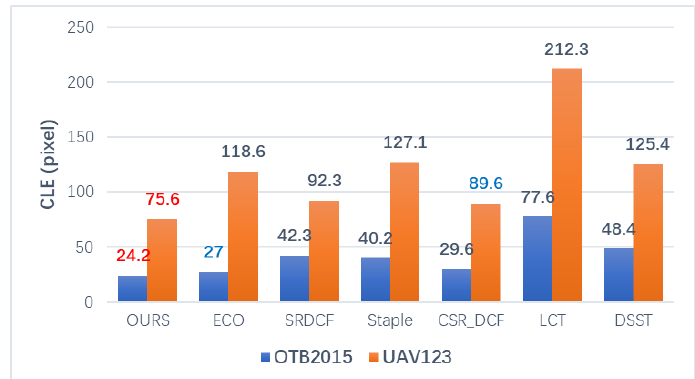
Figure 6. Comparison of center location error (CLE) on OTB 2015 and UAV123 datasets.